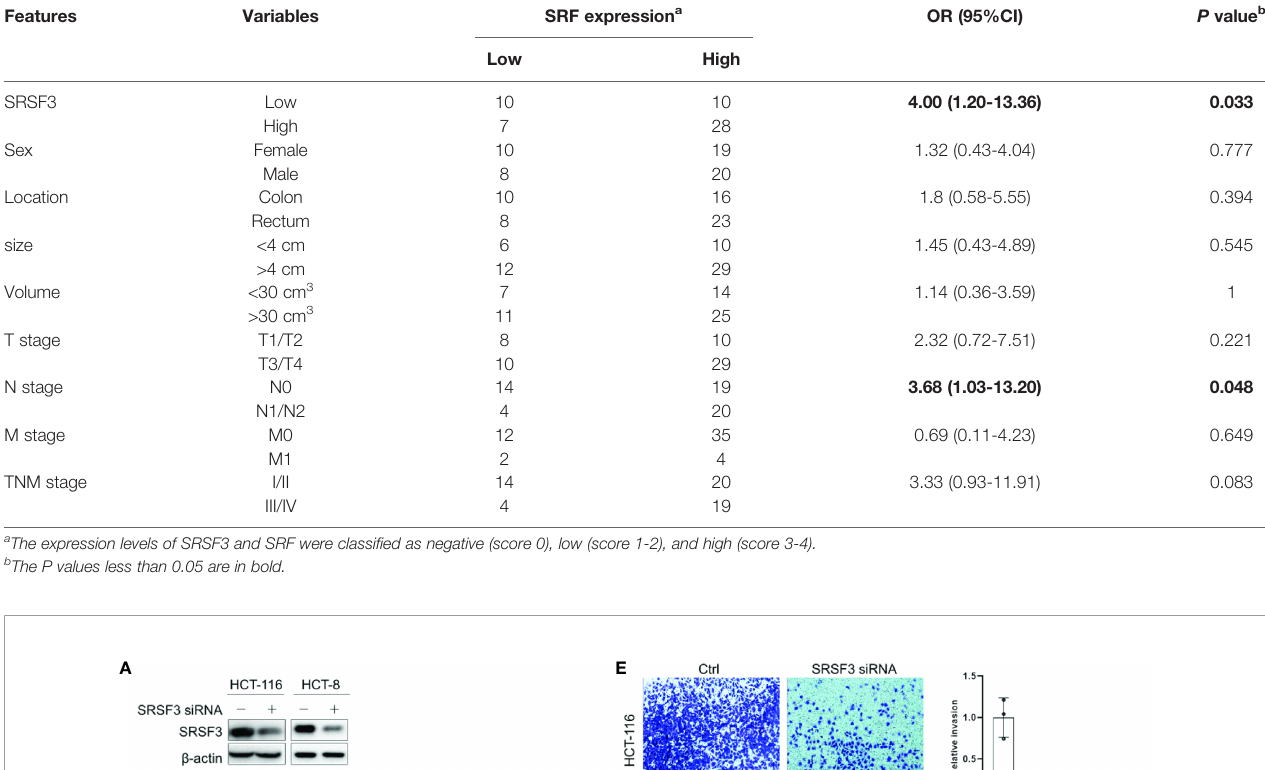
TABLE 1 | The relationship between SRF and clinical characteristics in CRC.